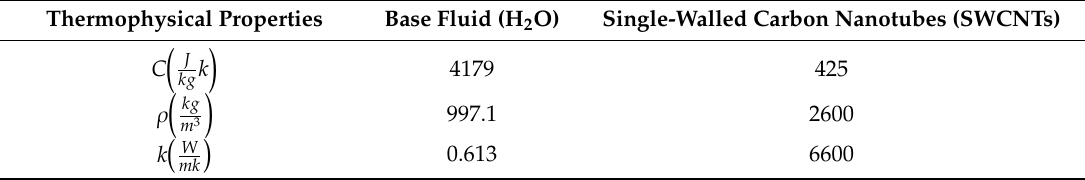
Table 1. Thermophysical characteristics of